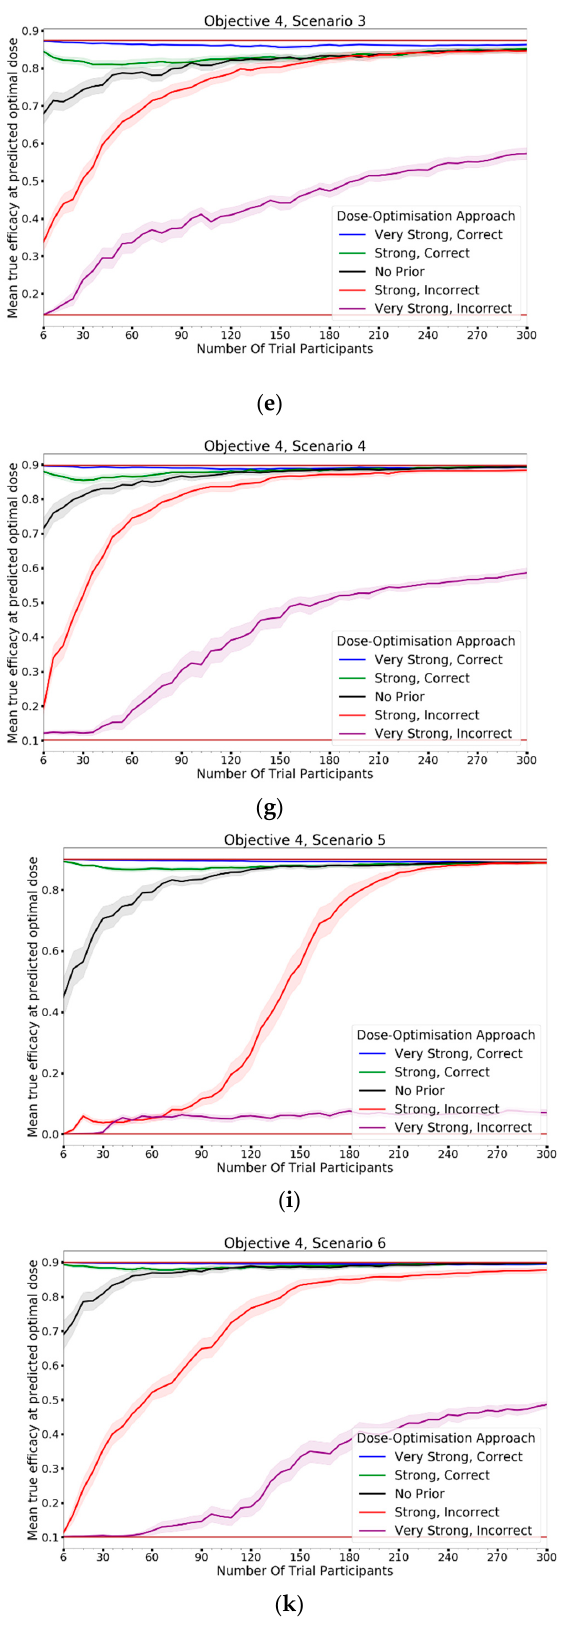
( n ) Figure 13. Mean true efficacy at the predicted optimal dose (S1–6, left), mean cumulative sum of efficacy (S1–6 6, right), mean true utility at the predicted optimal dose (S7, left), and mean cumula- tive sum of utility (S7, right) against trial size for all seven objective 4 scenarios (Scenario 1 ( a , b ), Scenario 2 ( c , d ), Scenario 3 ( e , f ), Scenario 4 ( g , h ), Scenario 5 ( i , j ), Scenario 6 ( k , l ), Scenario 7 ( m , n )). These are the mean values and 95%CI values across 100 simulations. For the true efficacy/utility at the predicted optimal dose plots (left), the brown lines show the minimum and maximum possible efficacy/utility that could be achieved in that scenario. For the cumulative efficacy/utility plots (right) the brown lines represent the maximum and minimum cumulative efficacy/utility sum that could be expected for that scenario. 4. Discussion In this work we used simulation studies to evaluate the Correlated Beta (CoBe) dose optimisation approach (DOA), a novel mathematical-modelling methodology for